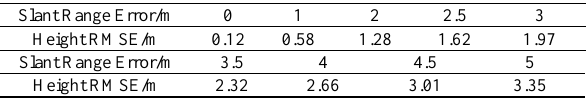
Table 2. Statistic results of the height error induced by slant range error